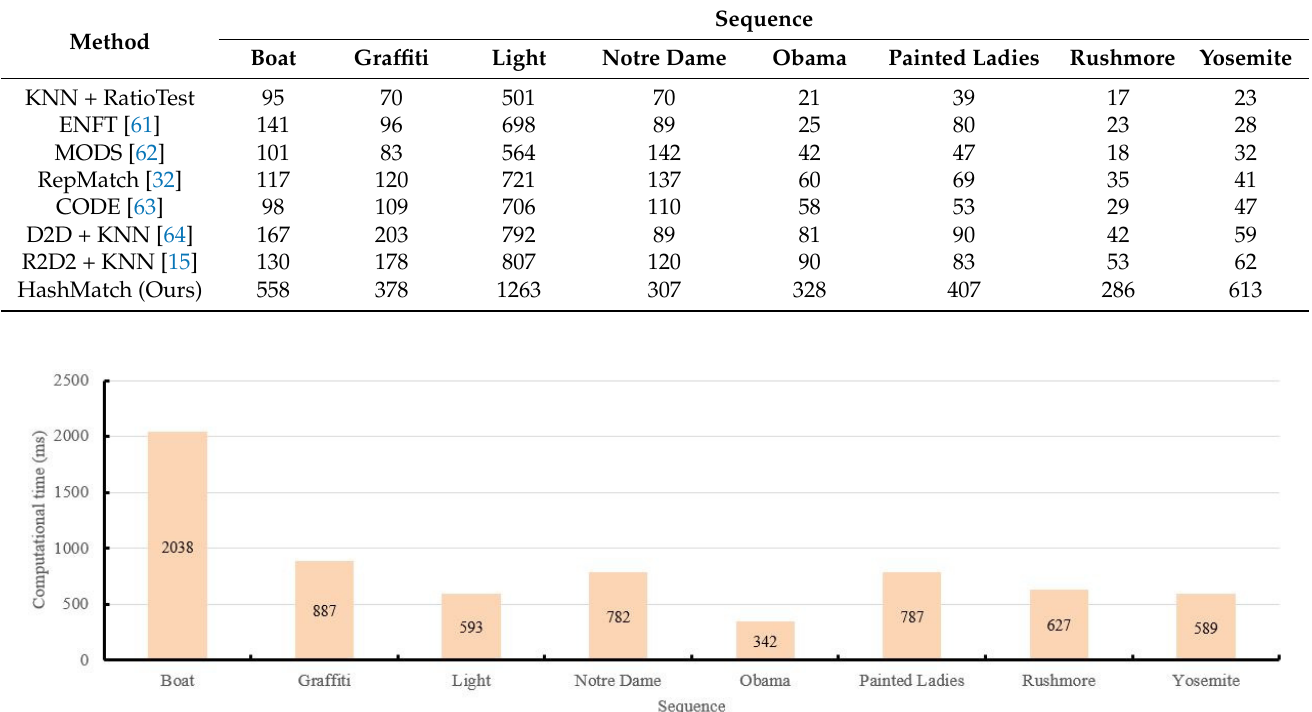
Figure 7. Computational times taken by the HashMatch on the Edge Foci dataset. These times consist of two parts, namely, feature detection time and feature matching time.